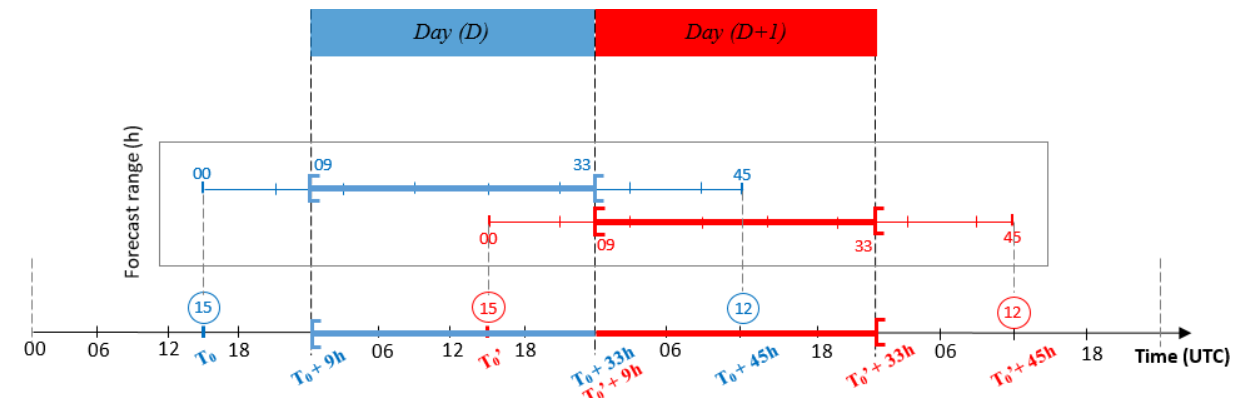
Figure 6. Illustration of meteorological forecasts used from AROME-EPS (in bold) as input to pX: the forecast starting from 15:00UTC on a day D is used to cover the next day D + 1.